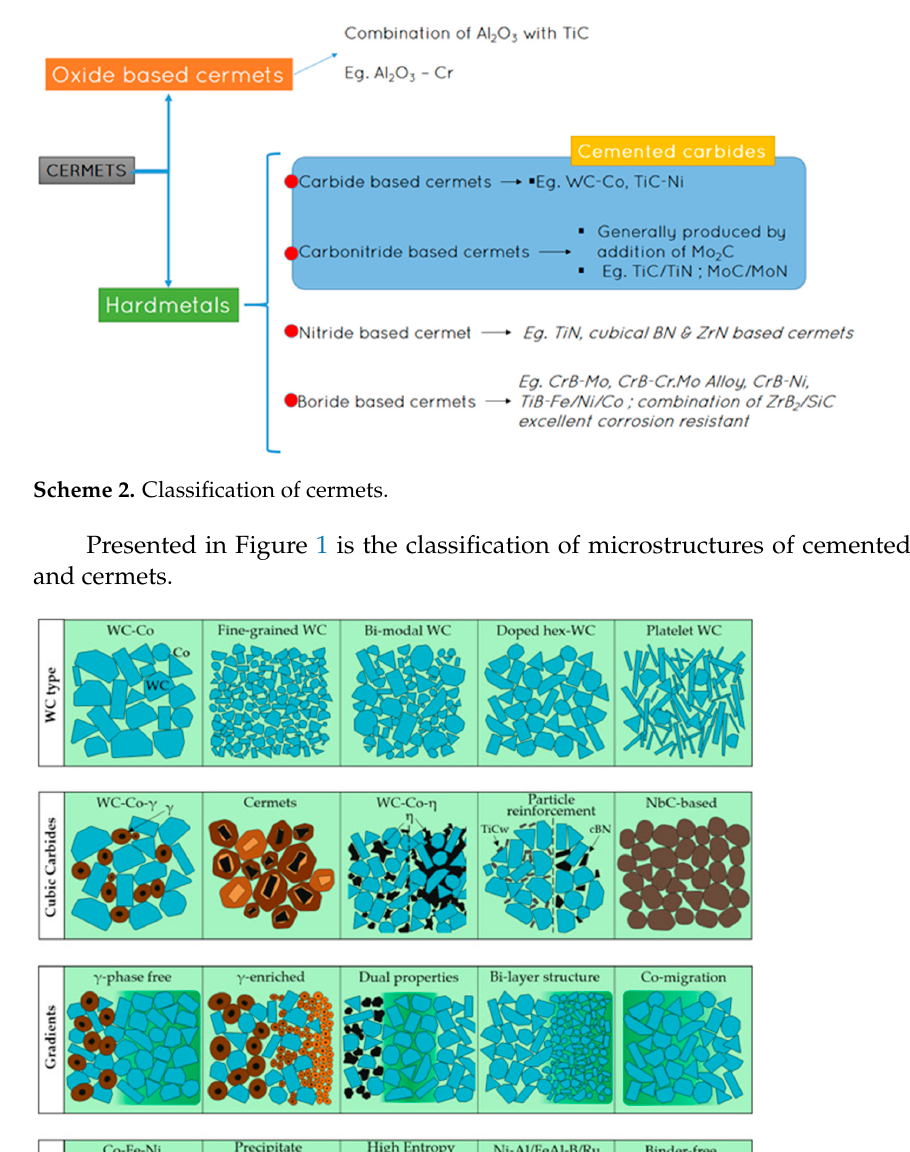
Figure 1. Categorization of cemented carbide microstructures. Reprinted from Ref. [18] with per- mission from Int. J. Refract. Metals Hard Mater.